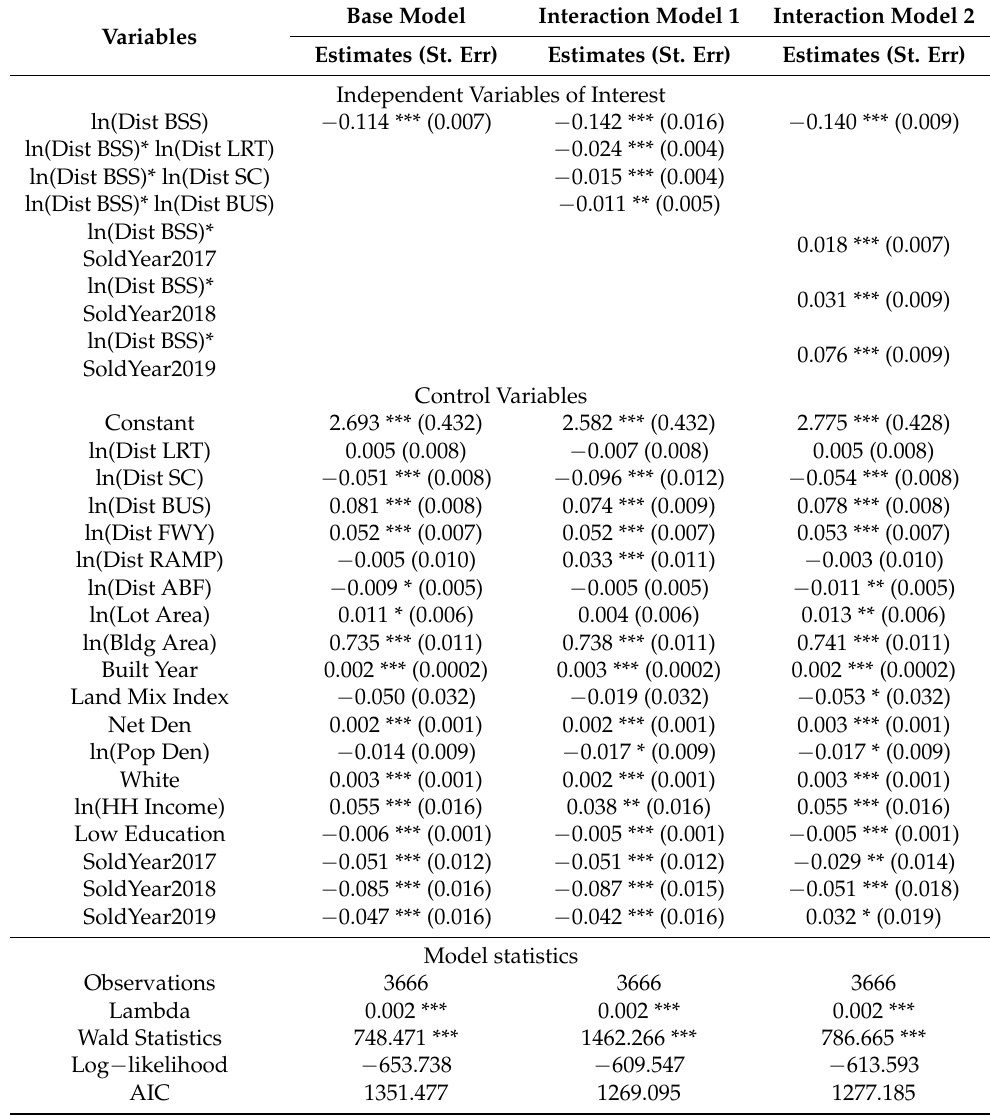
Table 6. Results of spatial error models in the multi-family housing